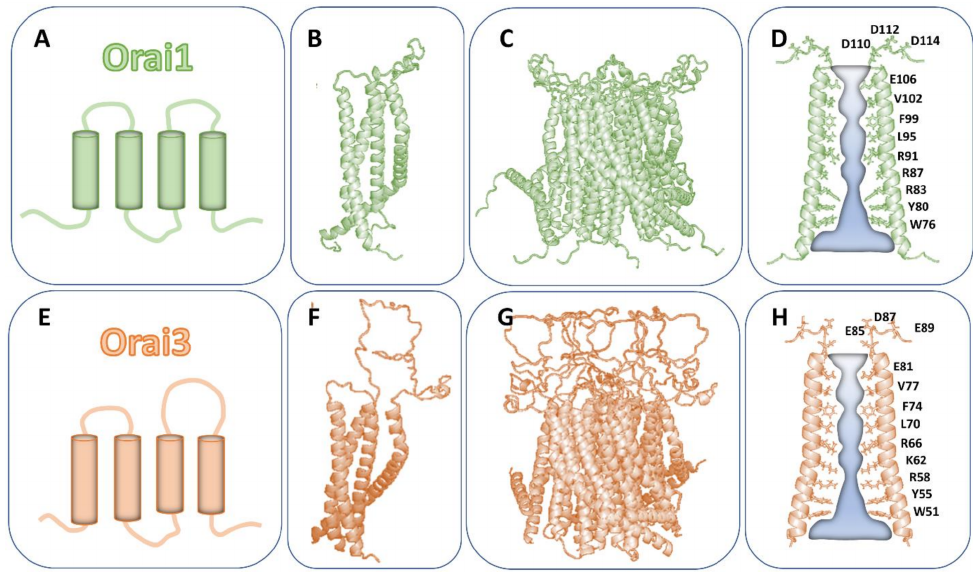
Figure 1. The Orai1 and Orai3 channel assembly. ( A ) The scheme visualizes the 4-TM domain structure of the Orai1 (green) channel with two extracellular and one intracellular loop. Both the N- and C-terminus are located in the cytosol. ( B ) The structure of the Orai1 subunit. ( C ) The side view of the Orai1 channel composed of six subunits from ( B ). ( D ) The pore of the Orai1 channel is highlighted by the most important pore-forming residues. ( E – H ) In analogy to Orai1 ( A – D ), ( E ) represents the scheme, ( F ) the single subunit, ( G ) the side view and ( H ) the pore of Orai3 (orange). Table 1. Orai domains and their sequence identity among the three Orai isoforms. Extent of Sequence Similarities of Orai